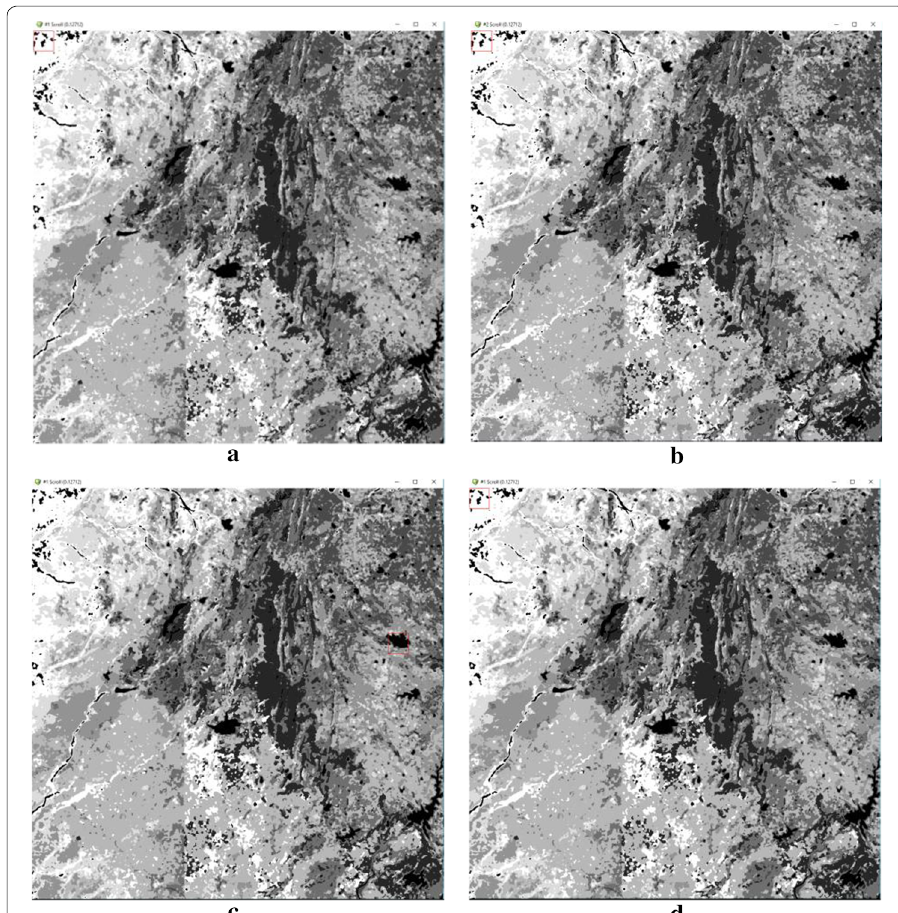
Fig. 9 Image after applying mode filtering with different window sizes